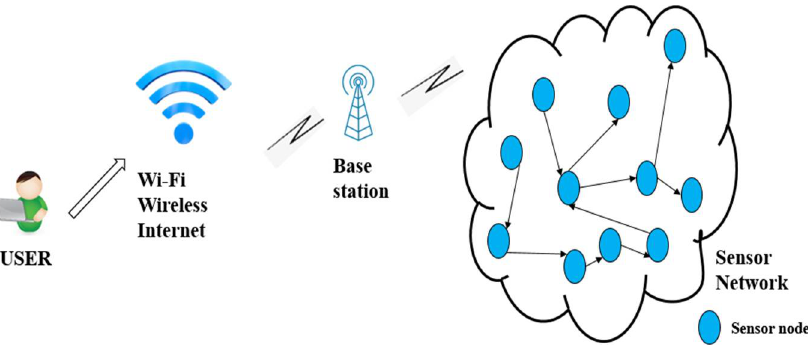
Figure 1. Scheme of typical WSN with multiple nodes.